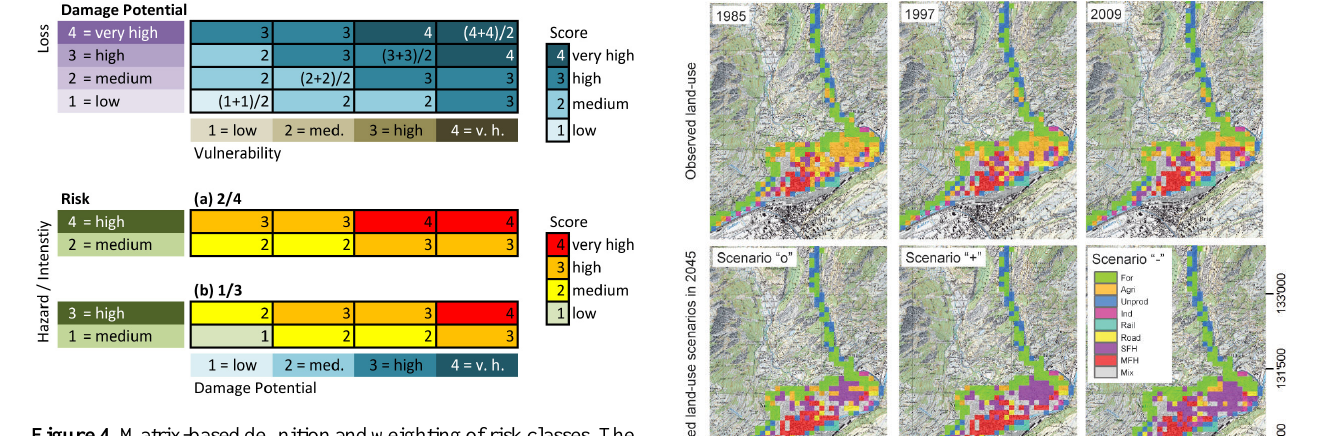
Figure 4. Matrix-based definition and weighting of risk classes. The risk parameters loss, vulnerability and the resultant damage poten- tial were assessed according to the first matrix, which illustrates the example of damage potential derivation. Risk was assessed accord- ing to the matrices (a) and (b) considering the damage potential and two quantifications of the hazard. The scores are a result of the mean of the value of both axes (rounded), as illustrated by means of four cells in the first matrix.